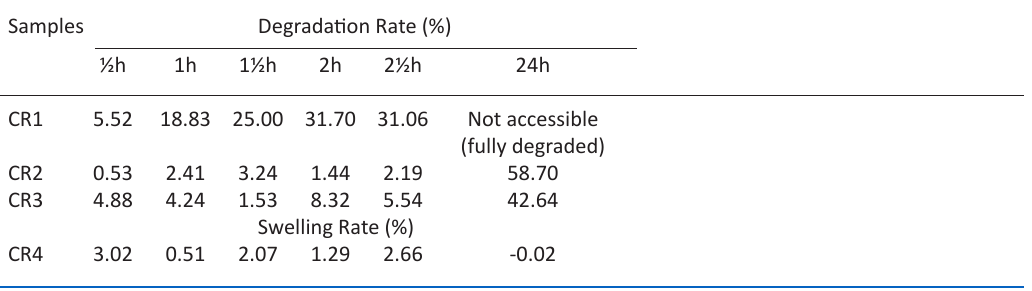
Table 3. Degradation rate of CR1, CR2 and CR3 and swelling rate of CR4 hydrogel